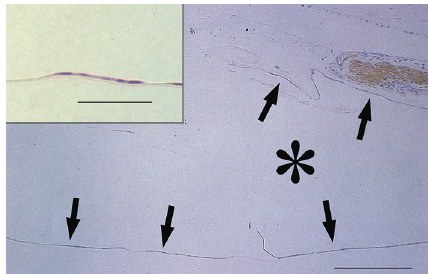
Figure 1: Immunolocalization of α -SMA in pseudophakic rabbit eyes 3 days after cataract surgery. A monolayer of LECs covers the inner surface of the anterior and central posterior capsules (ar- rows). These LECs are negative for α -SMA, although the sphincter muscles of the iris are positive for α -SMA. bar � 200 μ m. The inset shows a higher power view of LECs on the central posterior capsule. Bar � 50 μ m. Sections were stained with 3-3’-diaminobenzidine hydrochloride and counterstained with hematoxylin. The asterisk indicates the IOL